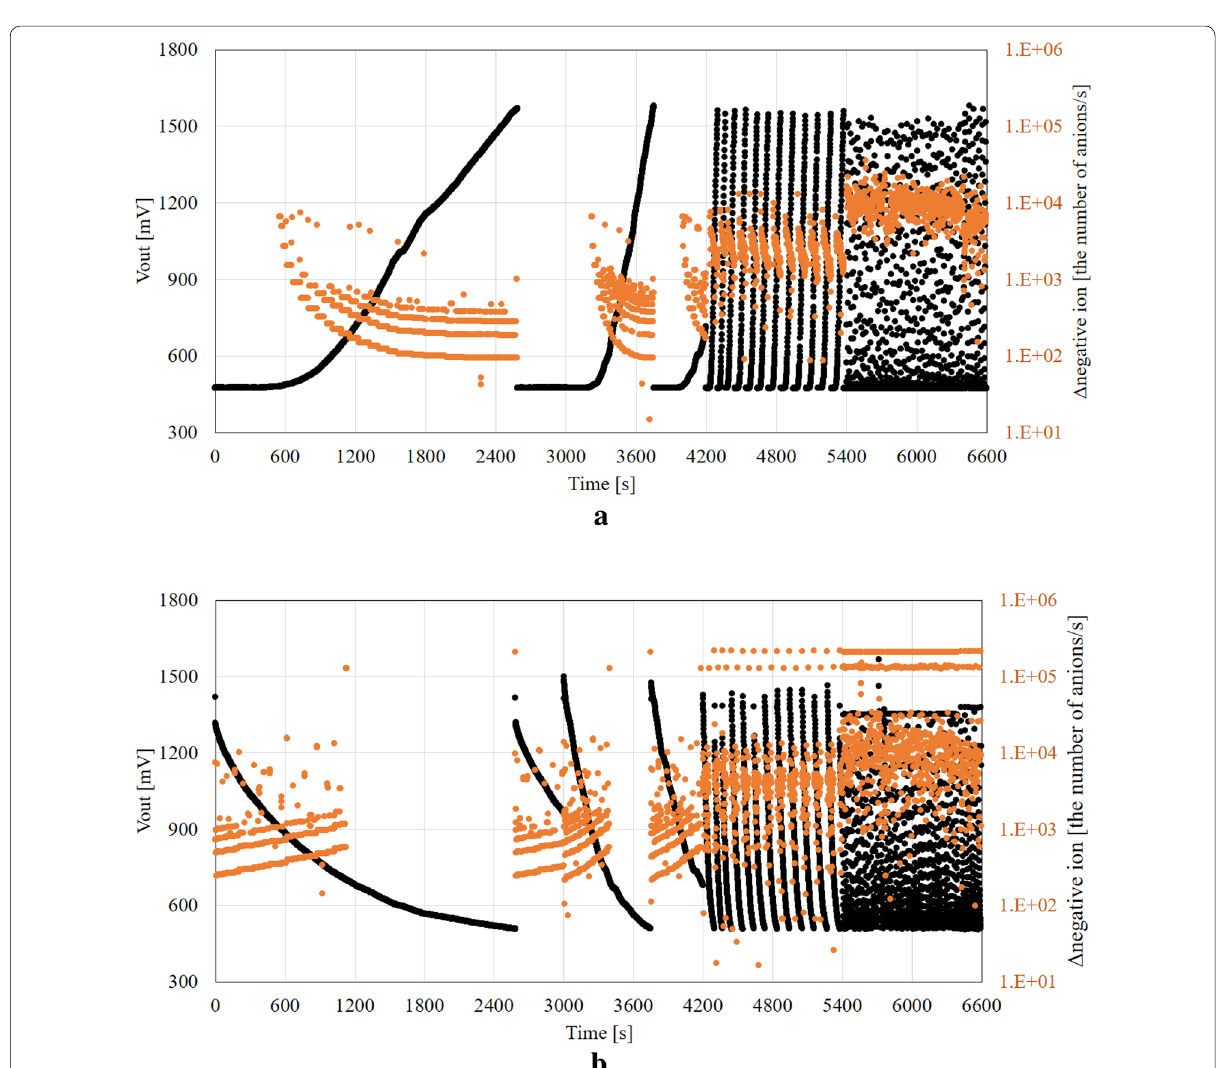
Fig. 3 Real‑time response to negative ions in four different ion concentration condition in the left y‑axis and the calculation of the number of negative ions adsorbed on the extended gate electrode per second in the right y‑axis; a p‑type nanoFET device, b n‑type nanoFET device